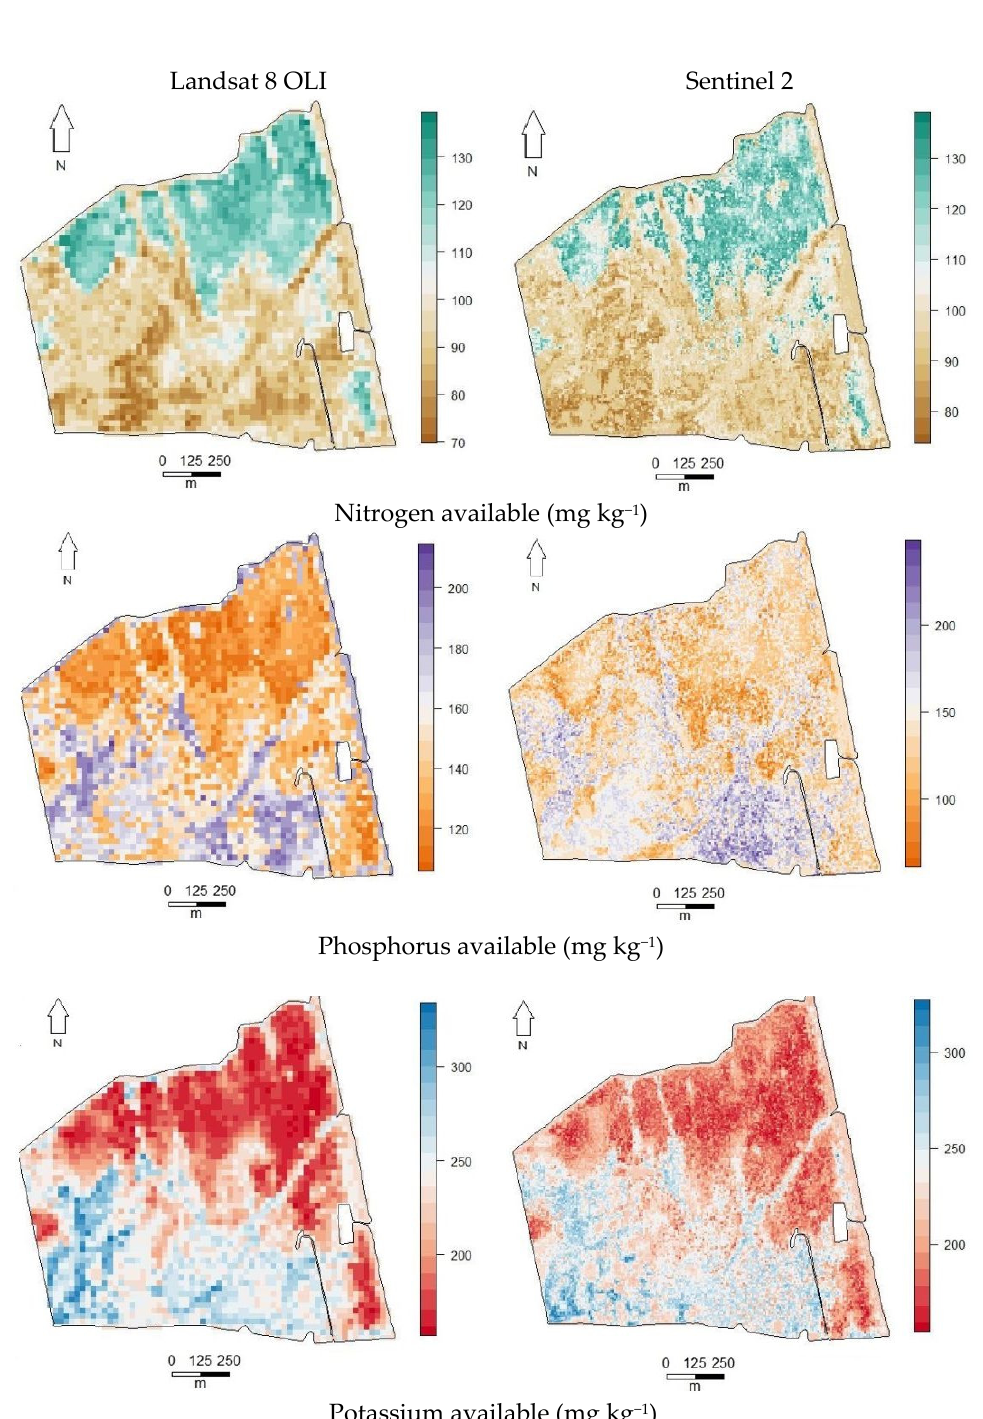
Figure 4. Final maps (SVMr) of agrochemical properties based on Landsat 8 OLI and Sentinel 2 data with soil indicators.